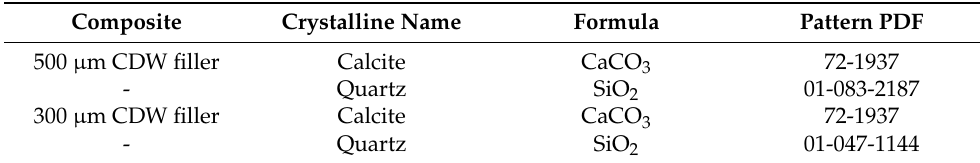
Table 6. Identified crystalline patterns contained in the filling powders of 500 µ m and 300 µ m used in composites